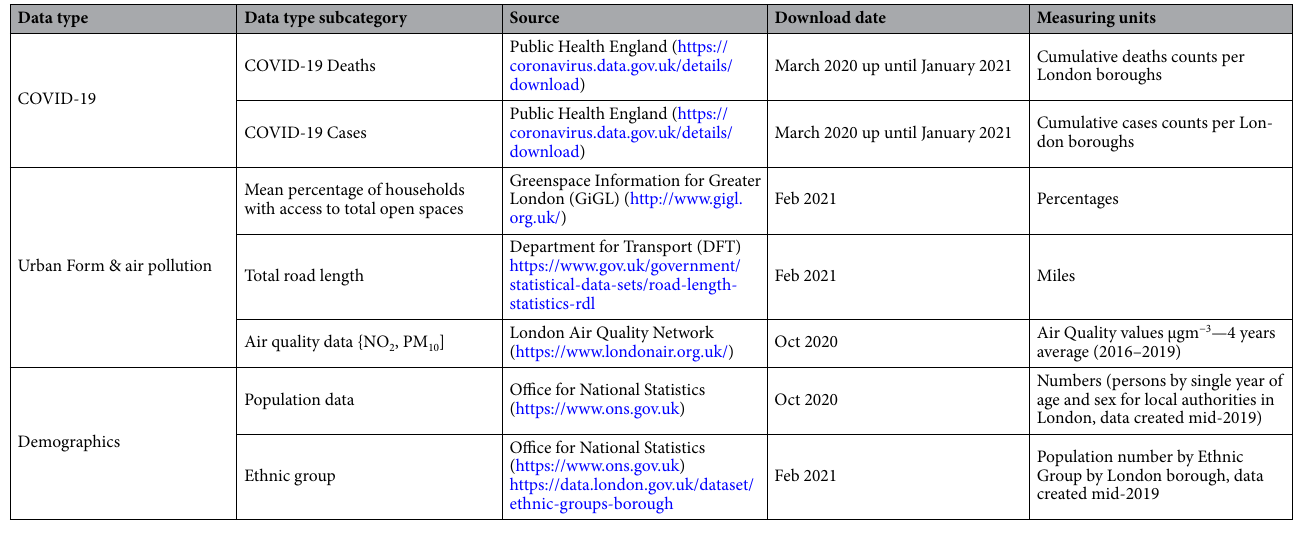
Table 1. Summary of data